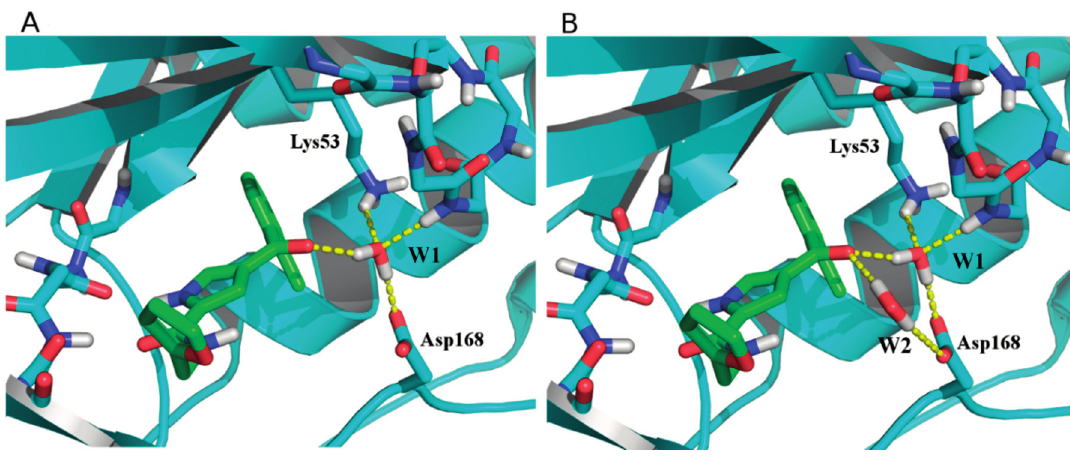
Figure 5. Hydrogen bond networks established by water molecules in 3MPT-1W ( A ) and 3MPT-2W ( B )